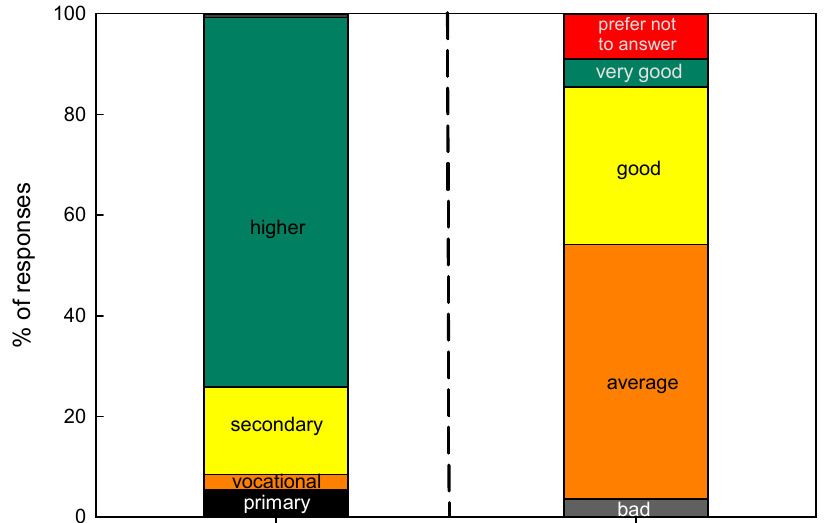
Figure 3. The level of education ( left bar ) and economic status ( right bar ) structure of questionees. In terms of economic status, there exists a general agreement between Ukraine, Portu- gal and Brazil. Between 49% and 58% of questionees declared the average economic status. In China, the dominant share of questionees (79.6%, n = 34) declared an average economic status, whereas, in Poland, the highest share of questionees (51.3%, n = 39) declared a good economic status. In general terms, an average economic status was declared by 50.6% ( n = 198), followed by 31.2% ( n = 122) of questionees who considered their economic status as good. An important conclusion to be drawn is that the questionees from different coun- tries may consider the same economic status differently. For the ones from the USA, the country with the highest level of AIC per capita in the world, the average economic status may have a very different meaning compared to the meaning it has for the questionees from the low-income countries, as the comparison is not accompanied by any numerical indicator but only by the very subjective opinion of the questionee. Nevertheless, the explained differences, especially in terms of place of living, education and economic status, influence the profile of the typical questionee. However, overall, the average questionee was a woman ( n = 260, SD = 91.3) between 21 and 65 years of age ( n = 314, SD = 159.6) with higher education ( n = 287, SD = 129.0) and an average economic status ( n = 198, SD = 79.7) who lives in city with more than 500k inhabitants ( n = 164, SD =